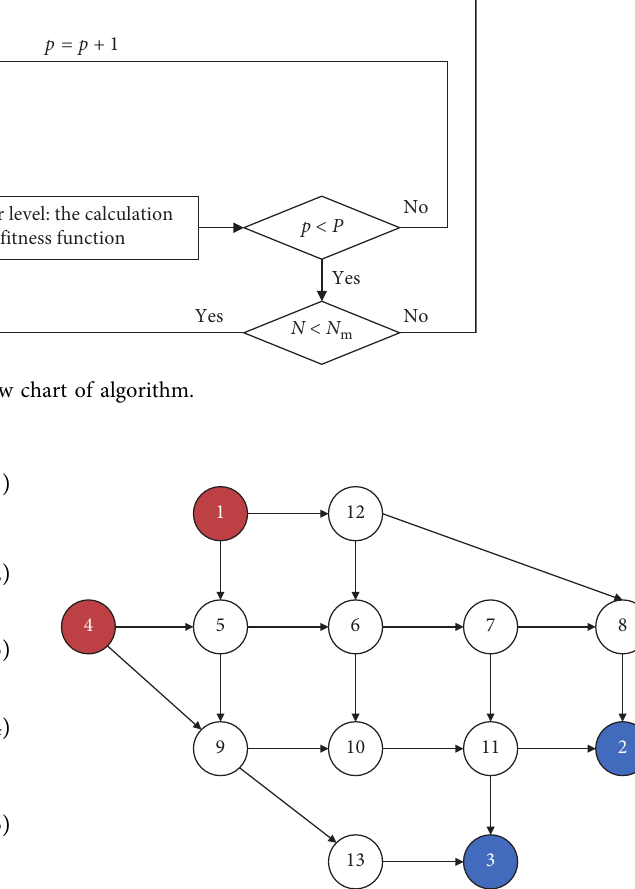
Figure 2: Nguyen–Dupuis network schematic diagram. Table 1: Basic traffic demand of each OD